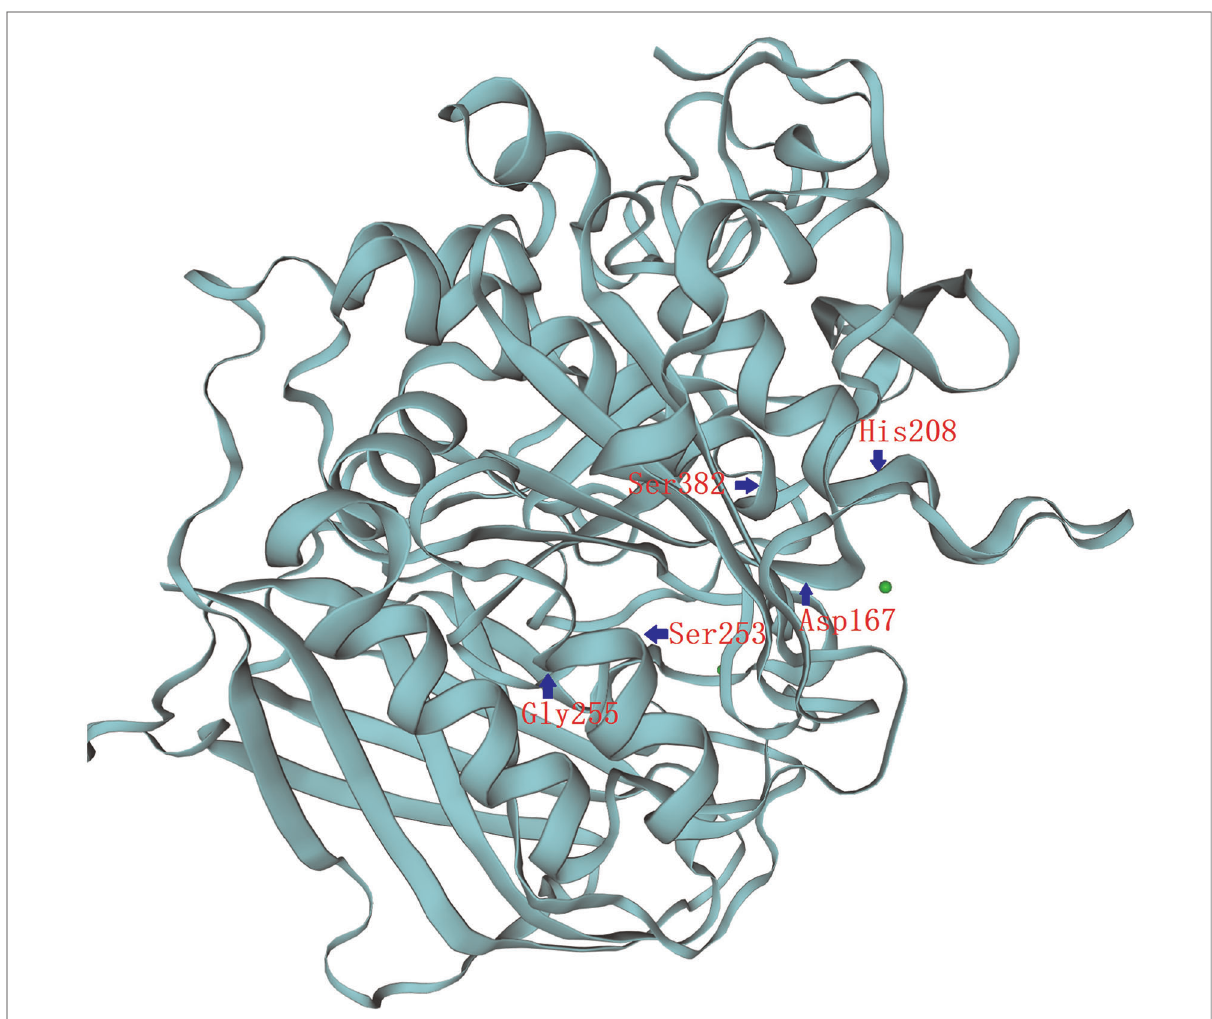
FIGURE 3 PCSK1 catalytic domain 3D structure. 3D representation of the full protein and catalytic domain of PC1/3, based on the crystal structure of PCSK1 using the Swiss model (swissmodel.expasy.org). Both variation sites of two residues, S253L&G255R, which closely nearby, are located in the exterior β -turn of the catalytic domain. The catalytic triad of Asp167, His208 and Ser382 residues have been